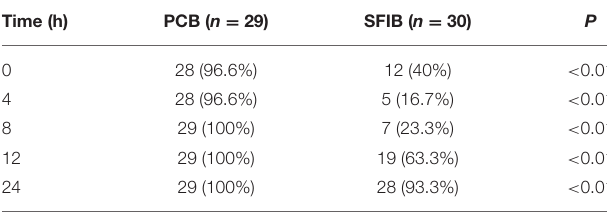
TABLE 3 | Percentage of patients with a NRS pain score ≤ 3.